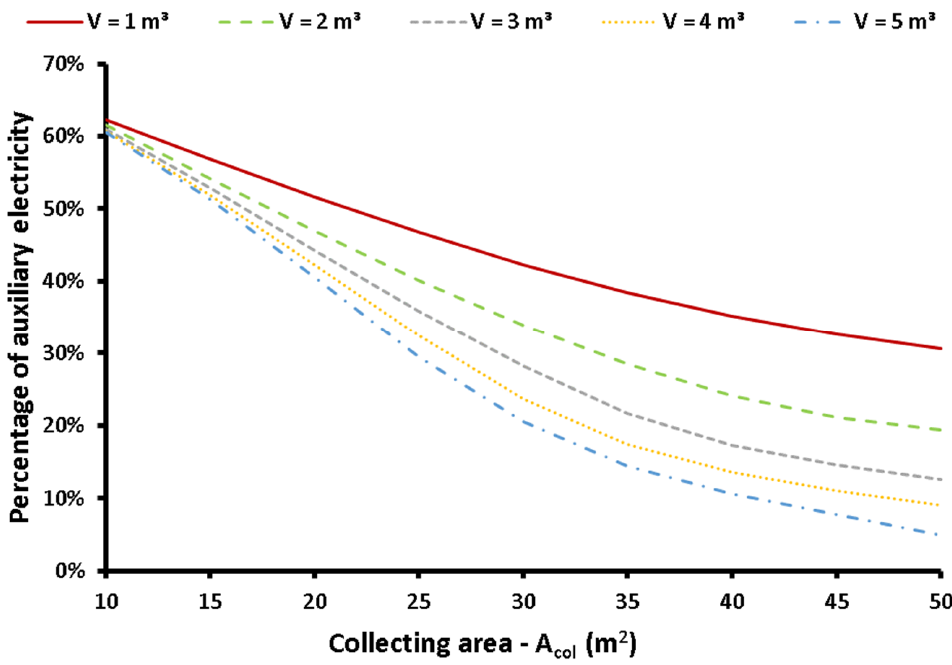
Figure 13. Percentage of the auxiliary electricity compared to the total electricity demand for different combinations of (A col ) and (V).